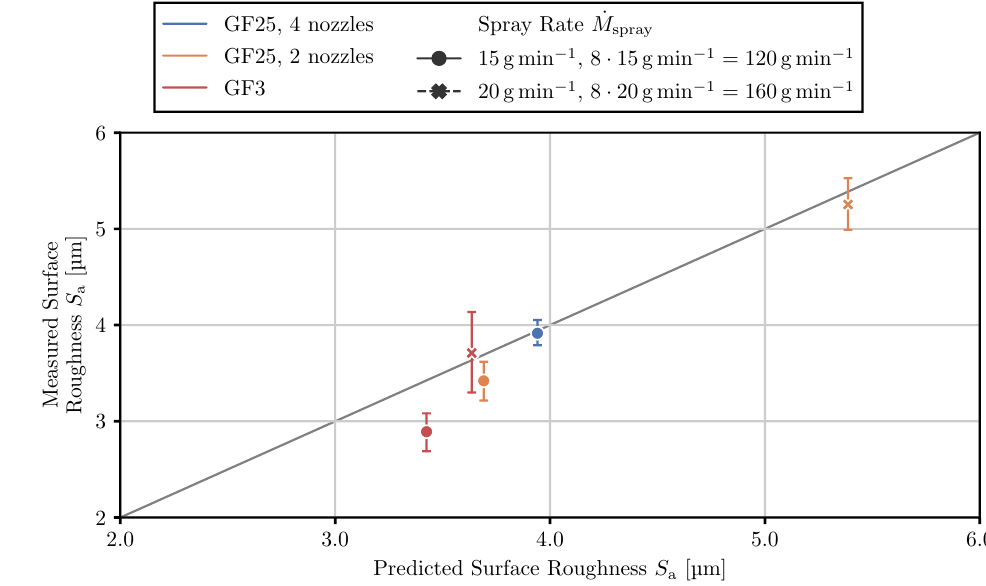
Figure 19. Parity plot comparing the measured surface roughness data for pilot-scale (GF25) and lab-scale (GF3) granulation experiments and the predicted roughness using the tracked quantity